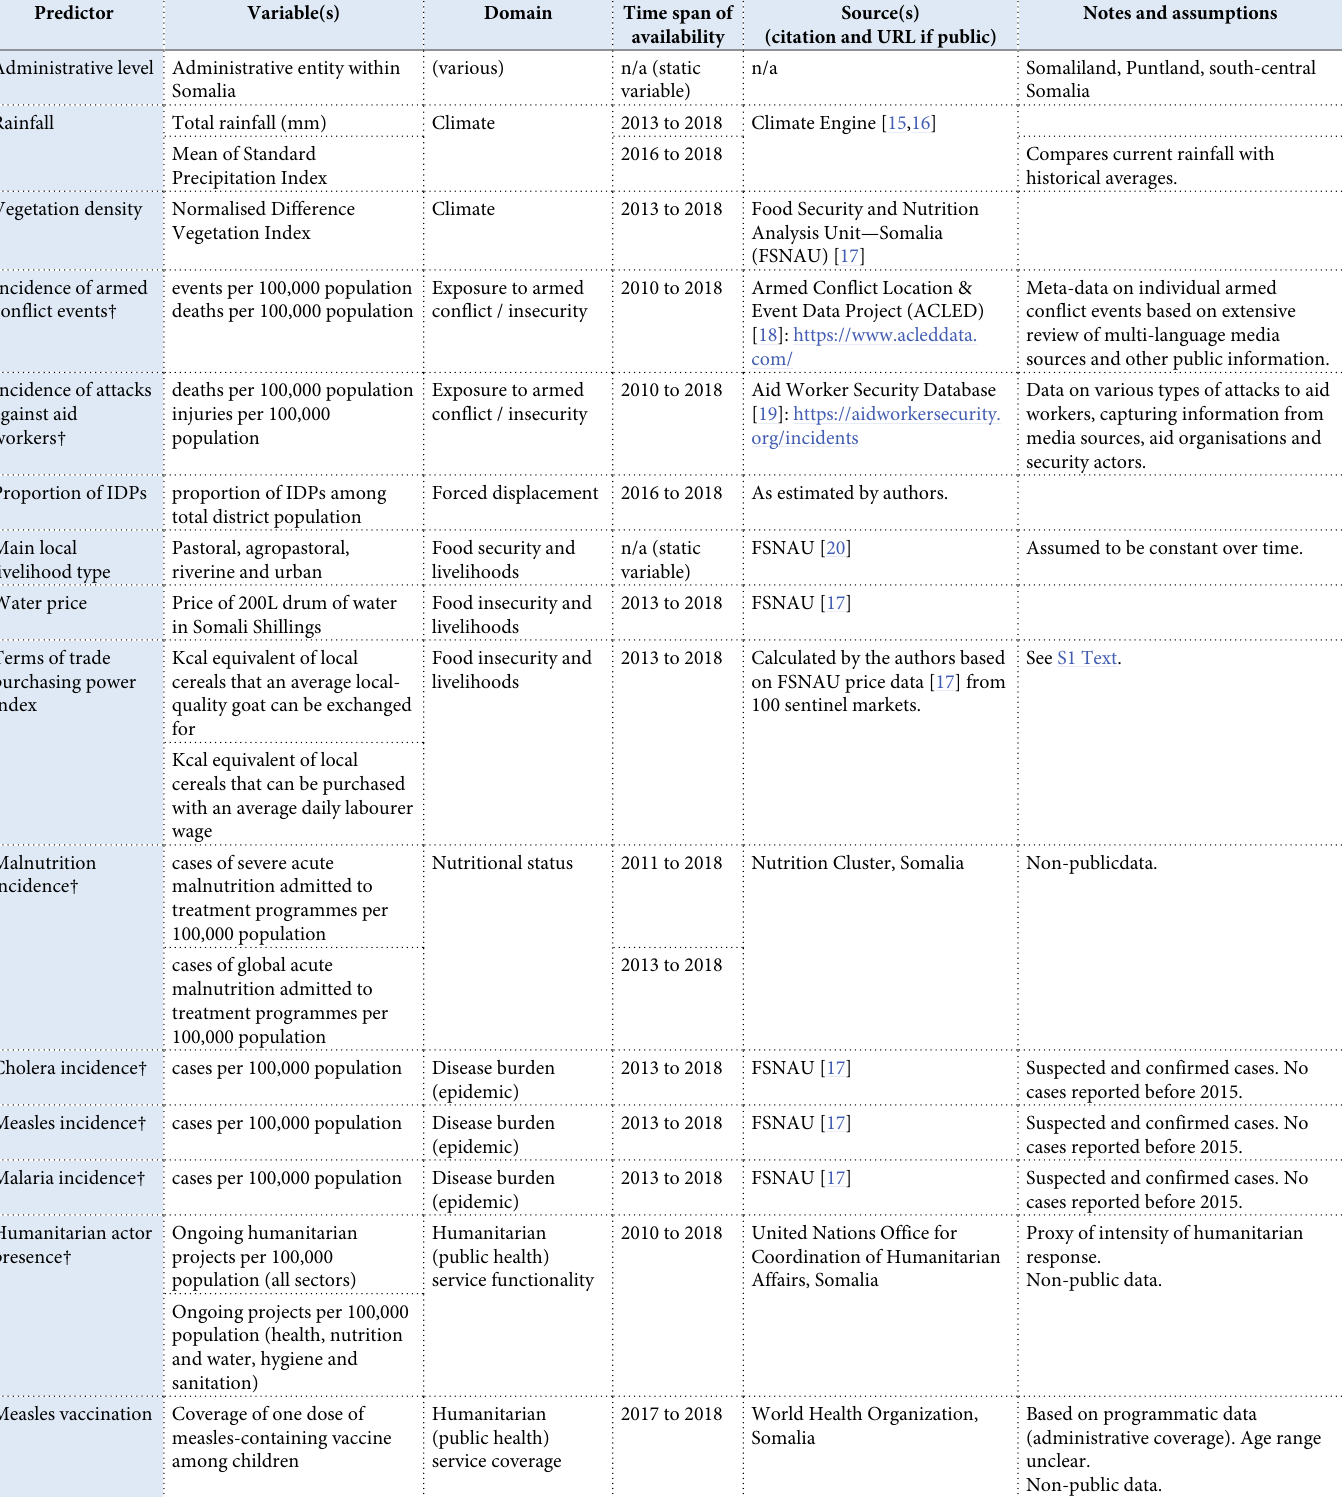
Table 1. Candidate predictors of mortality considered in the